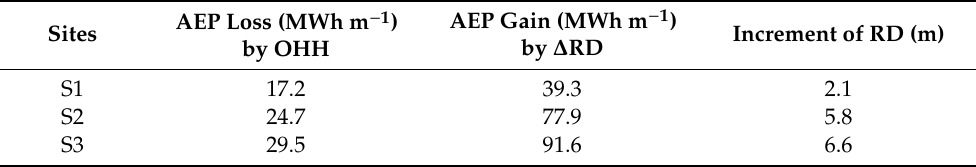
Figure 9. Distribution of increment rotor diameter for compensating for AEP loss.